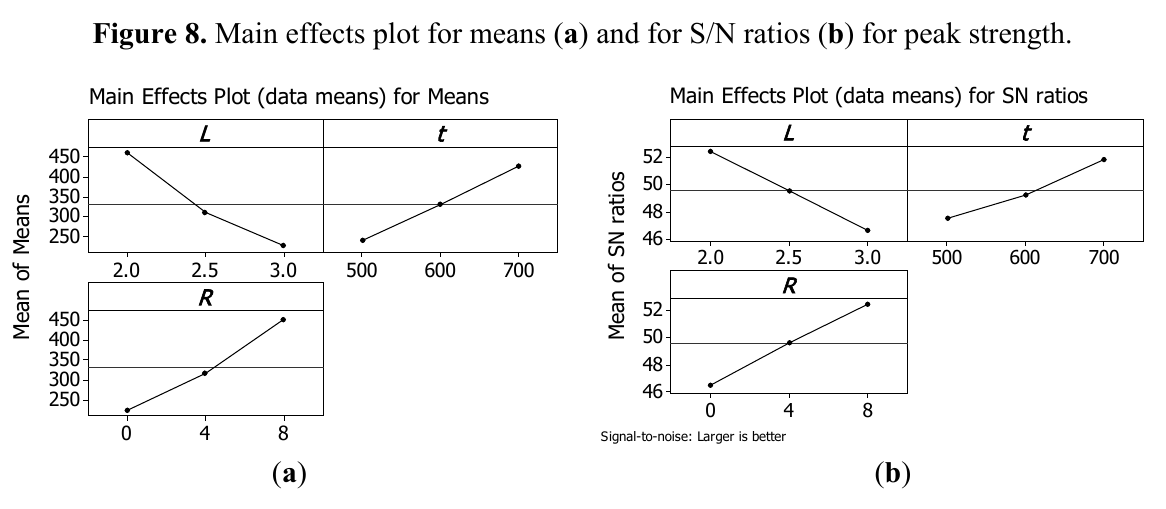
Figure 9. Main effects plot for means ( a ) and for S/N ratios ( b ) for energy absorbed per unit mass W m